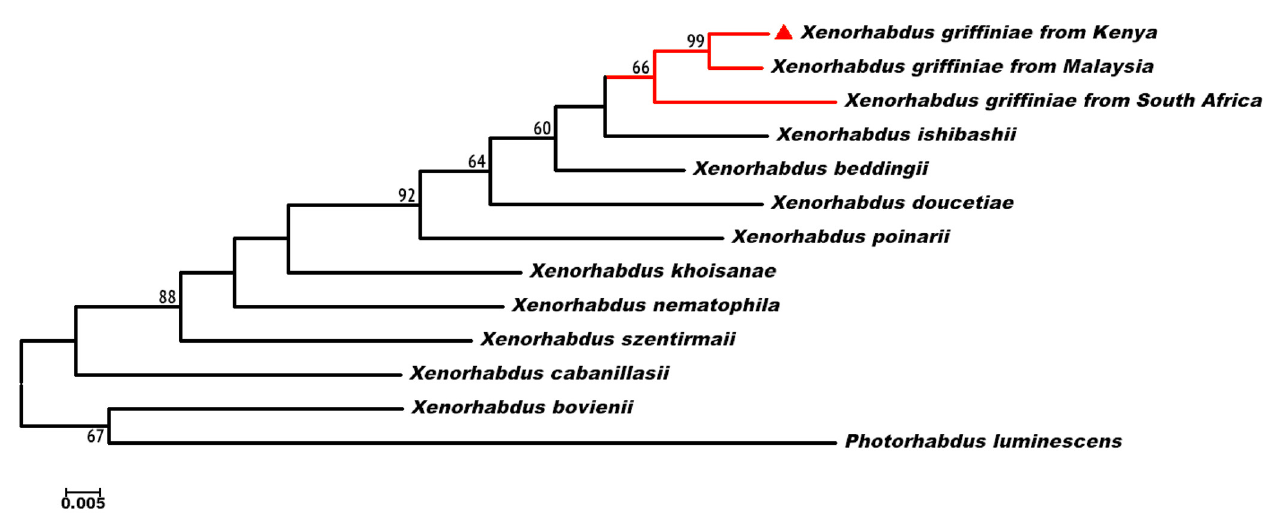
Figure 1. Phylogenetic tree of Xenorhabdus species based on the maximum likelihood method. The tree was based on a concatenate of ss-rRNA, recA, and serC gene sequences and was reconstructed with a general time reversal model and test of phylogeny of 500 bootstrap replicates. X. griffiniae isolated from this study (red triangle) clustered in the X. griffiniae clade (red), and was most closely related to X. griffiniae from